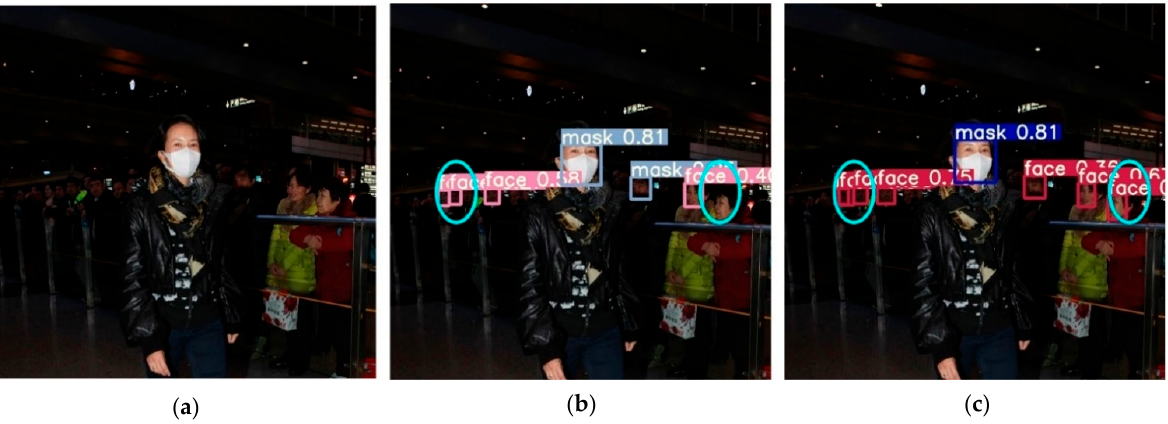
Figure 17. Detection of low light scenes. ( a ) Initial image sample; ( b ) YOLOv5 detect results; ( c ) YOLOv5-CBD detect results.